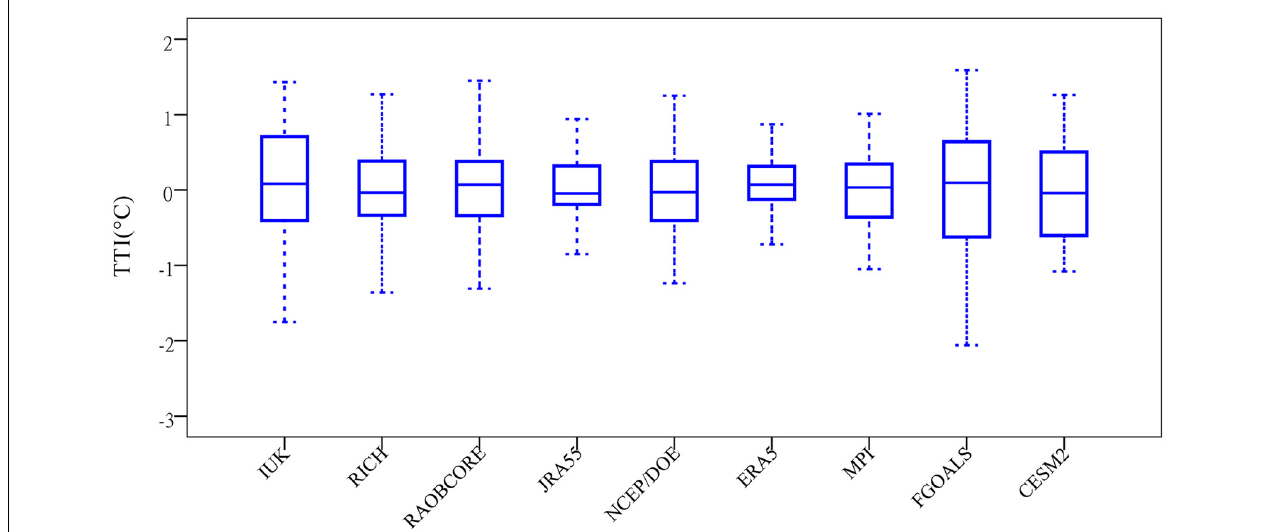
FIGURE 1 | Boxplot of the summer land–sea thermal contrasts (TTI) ( ◦ C).